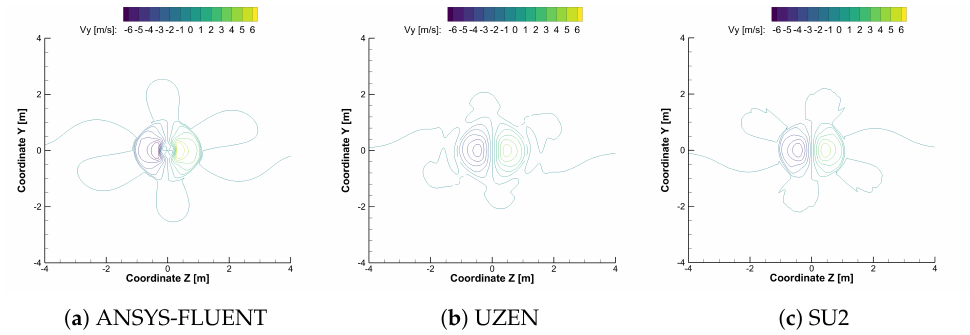
Figure 9. Comparison of y component velocity at section x = 30 m.